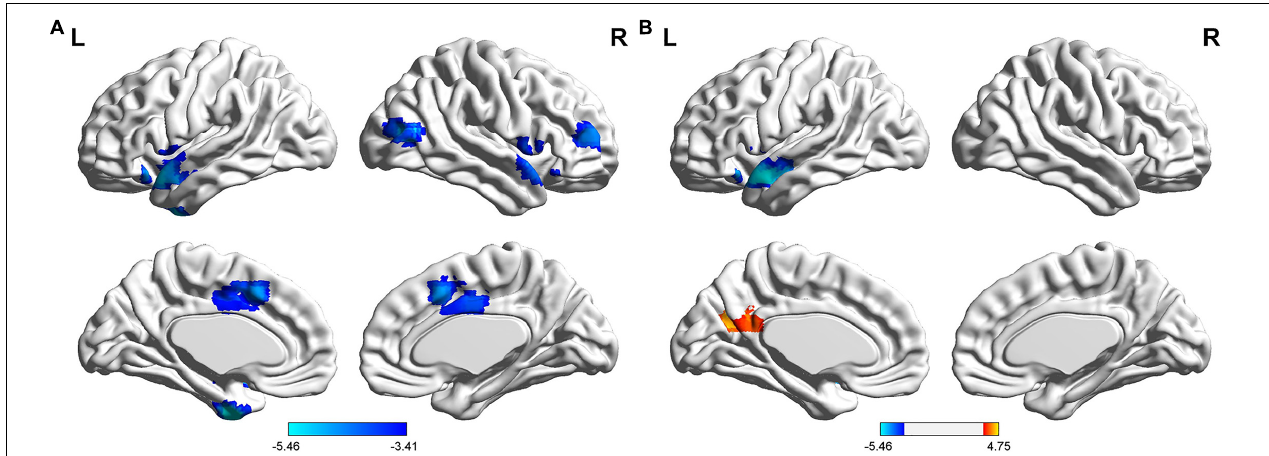
FIGURE 1 | Differences in resting-state functional connectivity between the T2DM group and the HC group (two-sample t -test, P < 0.05, Gaussian random field-corrected). (A) Lower connectivity of the left AG in the T2DM group. (B) Lower connectivity of the right AG in the T2DM group.